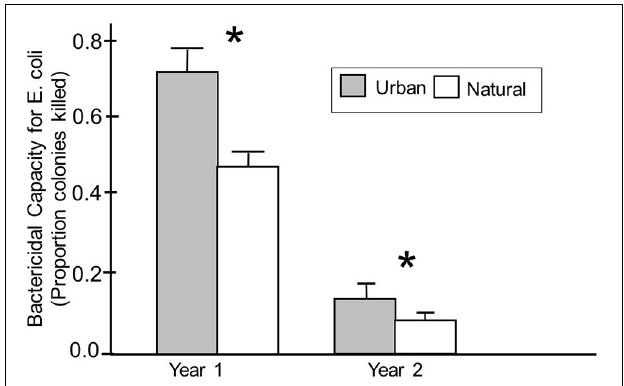
FIGURE 2 | Bactericidal capacity against E. coli in plasma from birds captured in urban and natural habitats in years 1 and 2 of the study. Habitats were classified based on behavior of birds at that site, particularly the likelihood that a bird would be habituated to humans at that site. Numbers inside each box indicate sample sizes, and an asterisk indicates a significant difference in bactericidal capacity between urban and natural birds based on Fishers PLSD analyses.